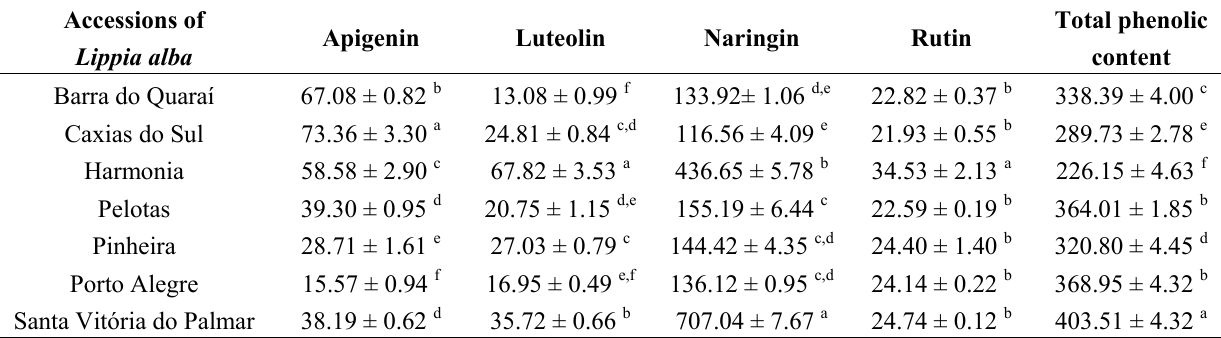
Table 2. Concentration of the main flavonoids (µg/g of dry leaves) and total phenolic content (equivalents of gallic acid/dry leaves; mg/g) in the different accessions of Lippia alba . Accessions of